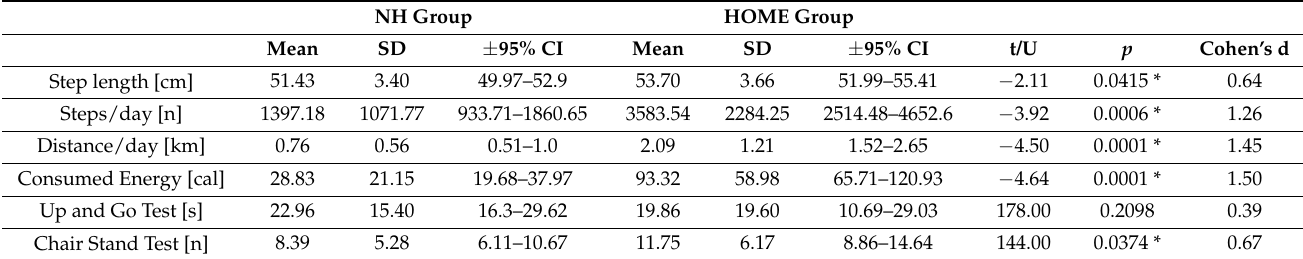
Table 2. Physical activity and functional physical fitness of the subjects.